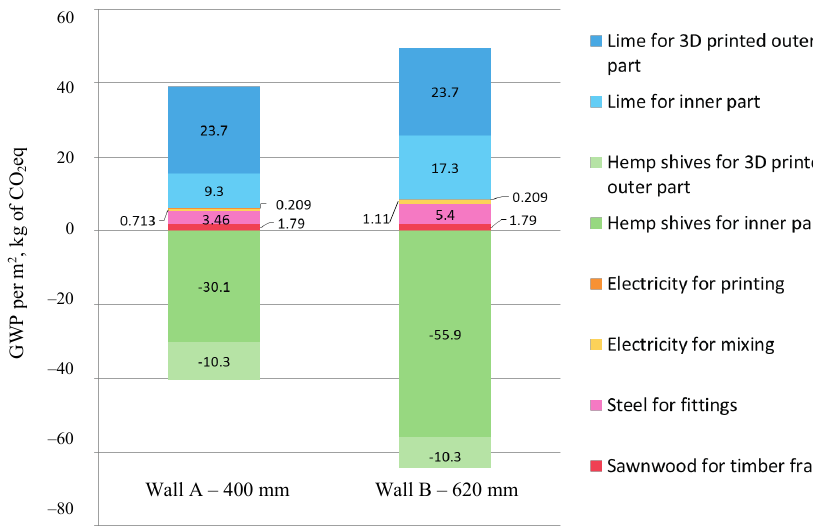
Fig. 5. Distribution of GWP between the different components of 3D printed hempcrete